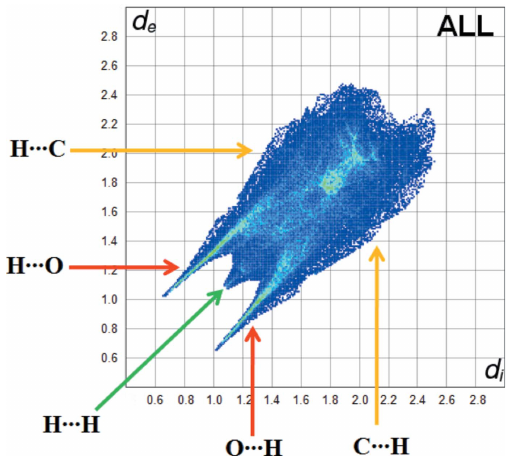
Figure 5 The fingerprint plot of the title compound.